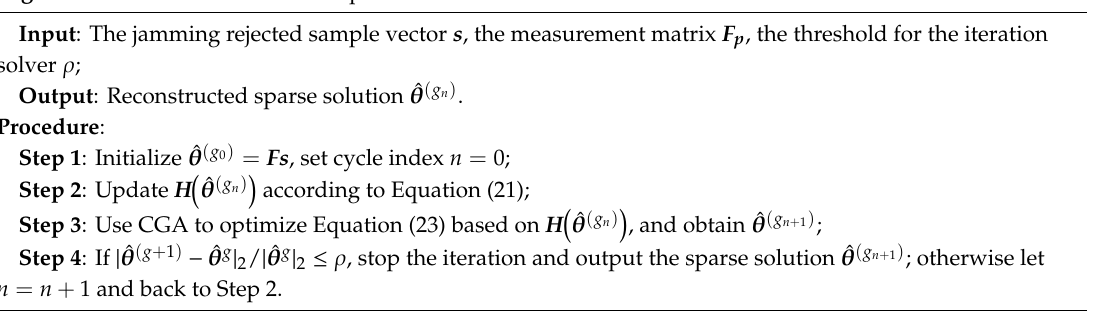
Algorithm 1 Alternate Iteration Optimization for BCS Reconstruction